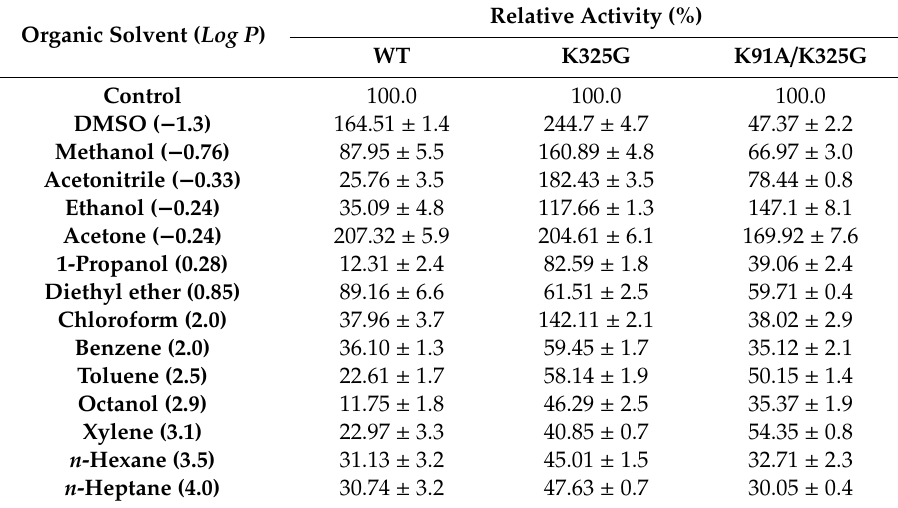
Table 3. E ff ect of organic solvents on WT, K325G, and K91A / K325G lipase activity. Organic Solvent ( Log P